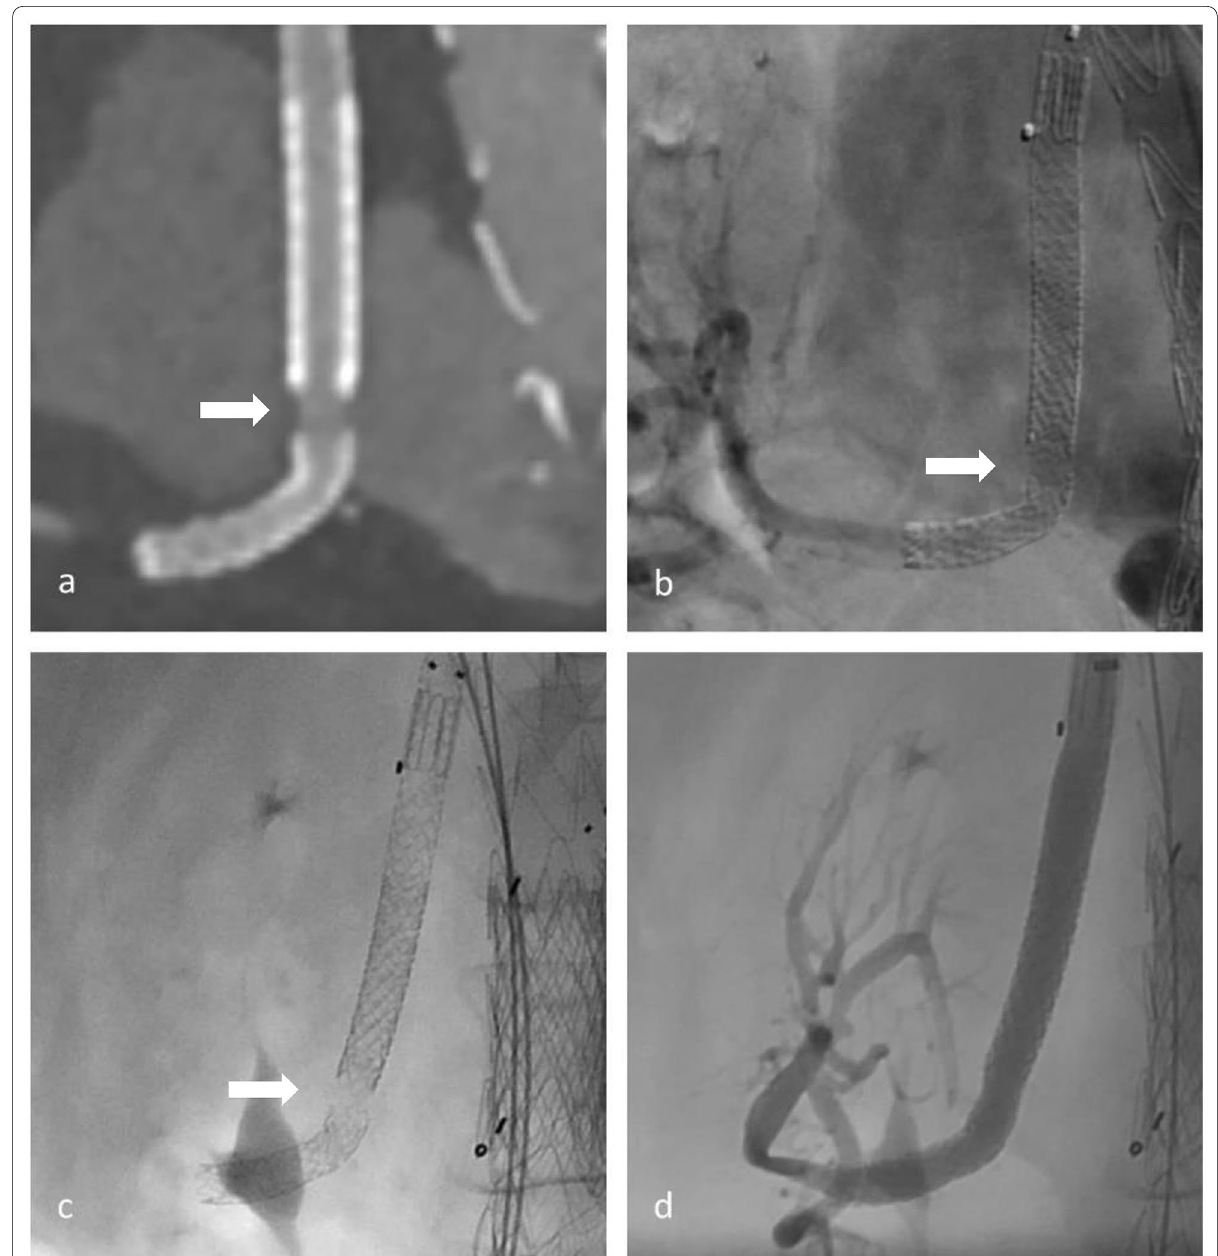
Fig. 1 Complete separation of right renal BSG with endoleak directly diagnosed at CTA ( a ), during angiography ( b , c ) and after successful